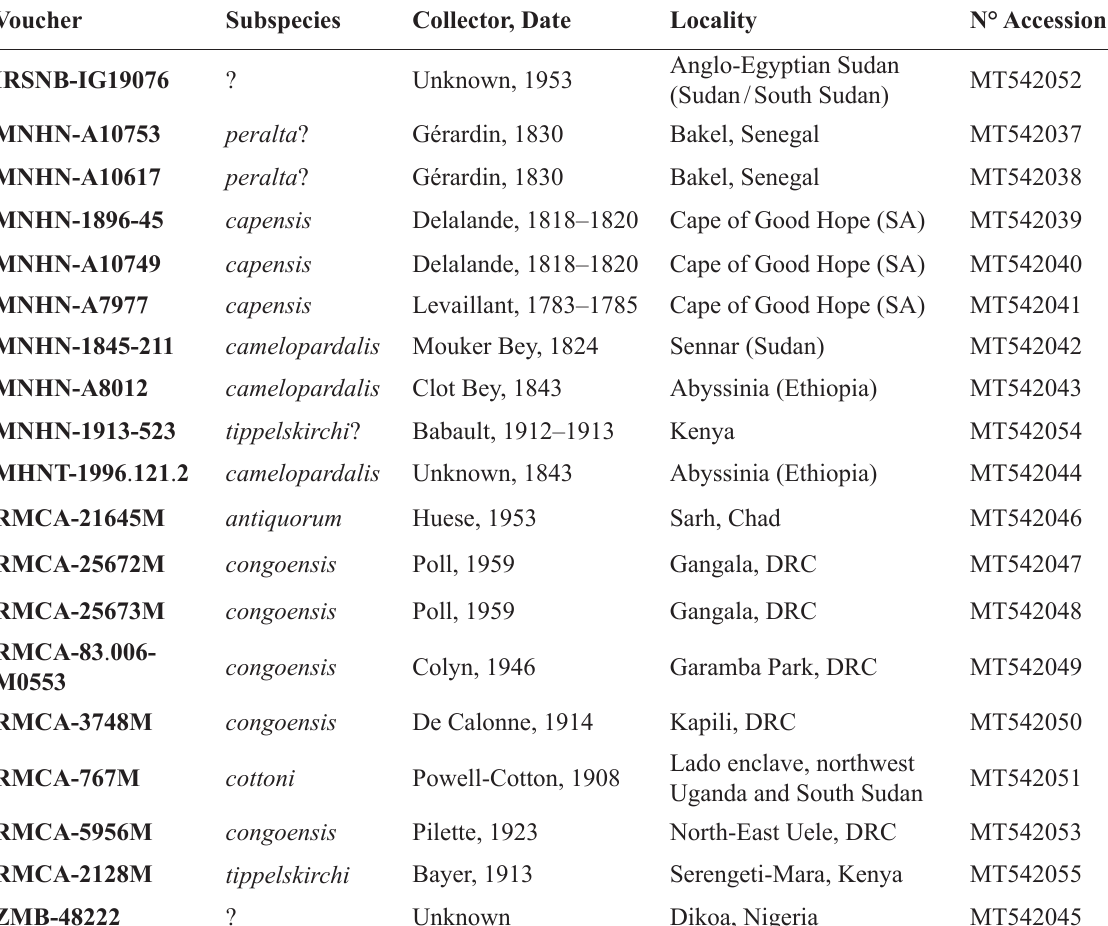
Table 2. Museum specimens sequenced in this study (subspecies assignations have been made by morphological characters or distribution range). DRC = Democratic Republic of the Congo; SA = South